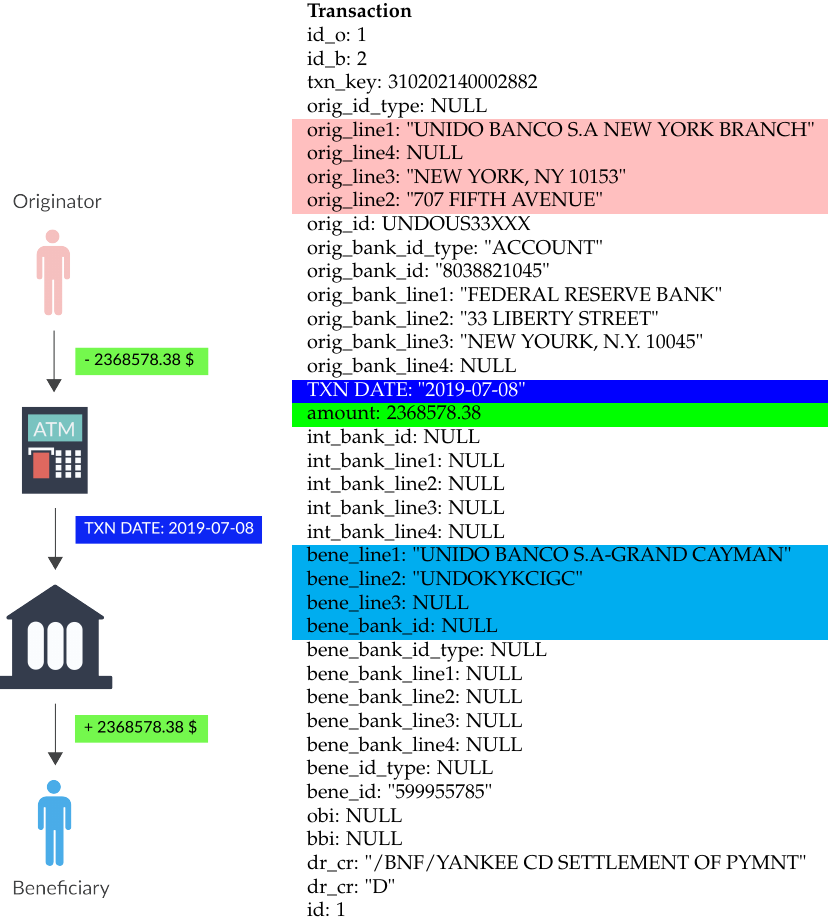
Figure 2. Structure of a transaction